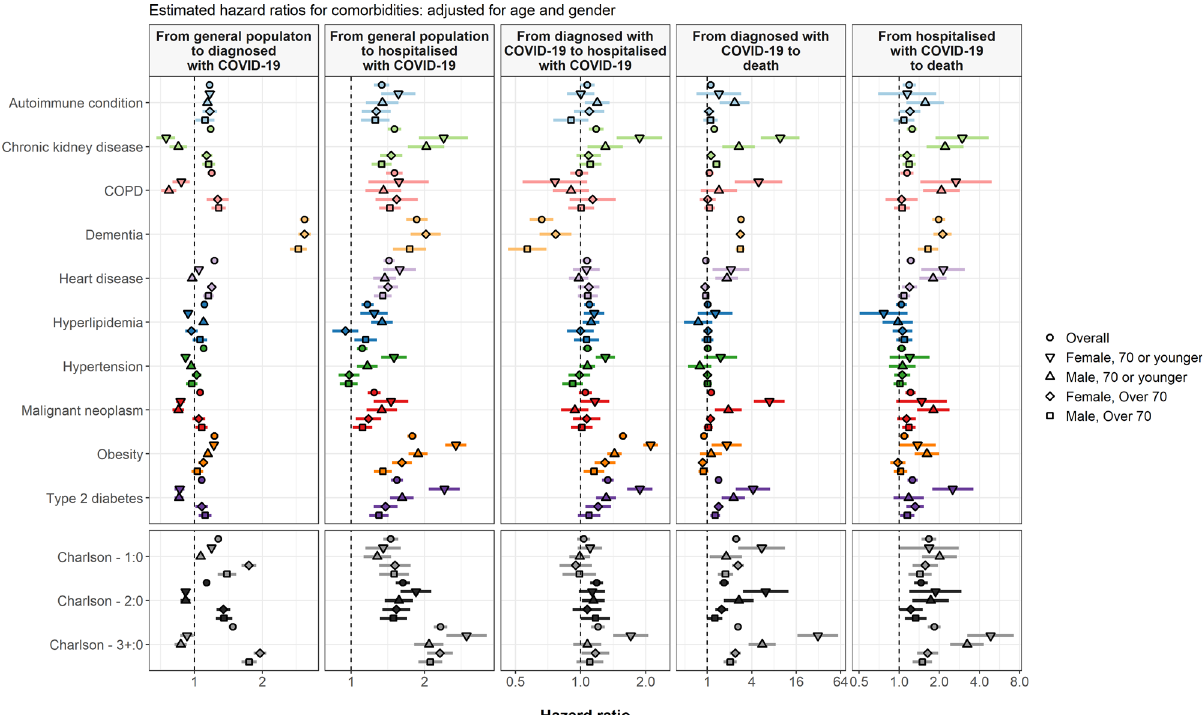
Fig. 6 Comorbidities and COVID-19 transitions. Estimated hazard ratios for comorbidities of interest from cause-speci fi c Cox models for each transition. Points give estimated hazard ratios, with lines representing 95% con fi dence intervals. Models were estimated separately for each comorbidity of interest, with adjustment for age and sex. COPD chronic obstructive pulmonary